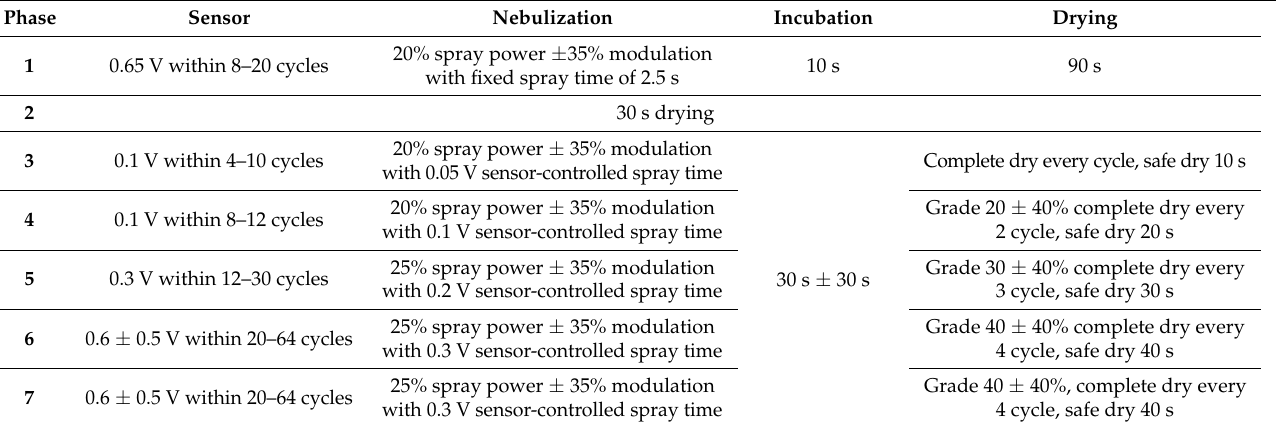
Table 2. Settings used for deposition of HCCA matrix with the ImagePrep